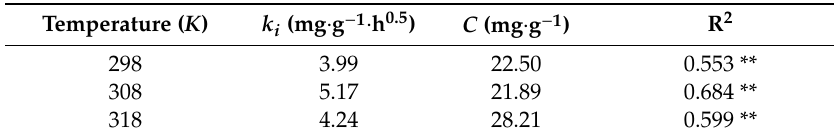
Table 3. Intraparticle di ff usion coe ffi cients and intercept values for U(VI) adsorption on HA particles at di ff erent temperatures.